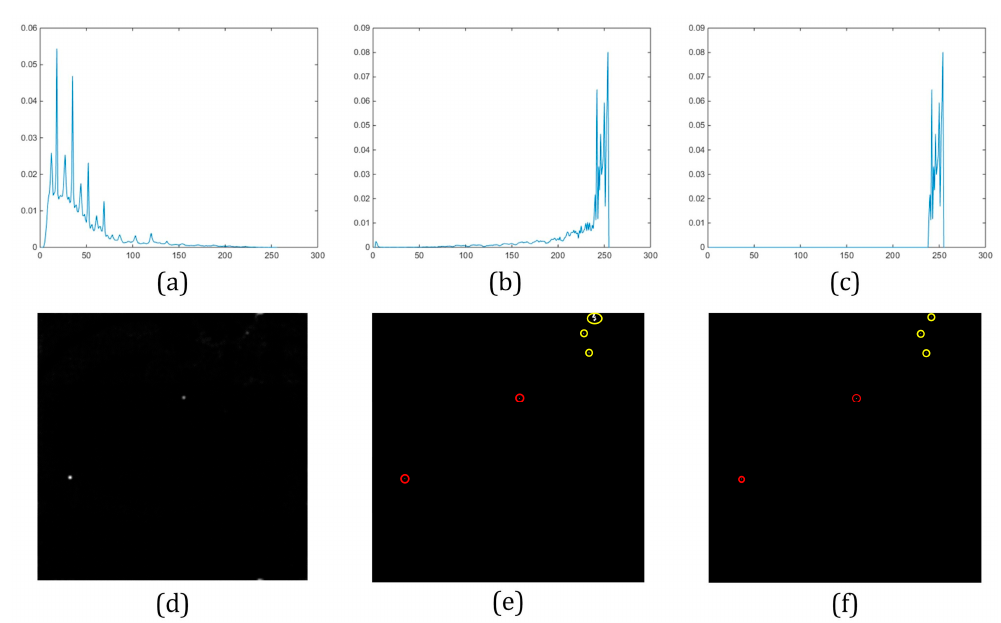
Figure 5. In-frame detection results of Seq.1 generated by our method: ( a ) intensity histogram; ( b ) original saliency histogram; ( c ) modified saliency histogram; ( d ) saliency map; ( e ) binarized image; ( f ) in-frame detection result.